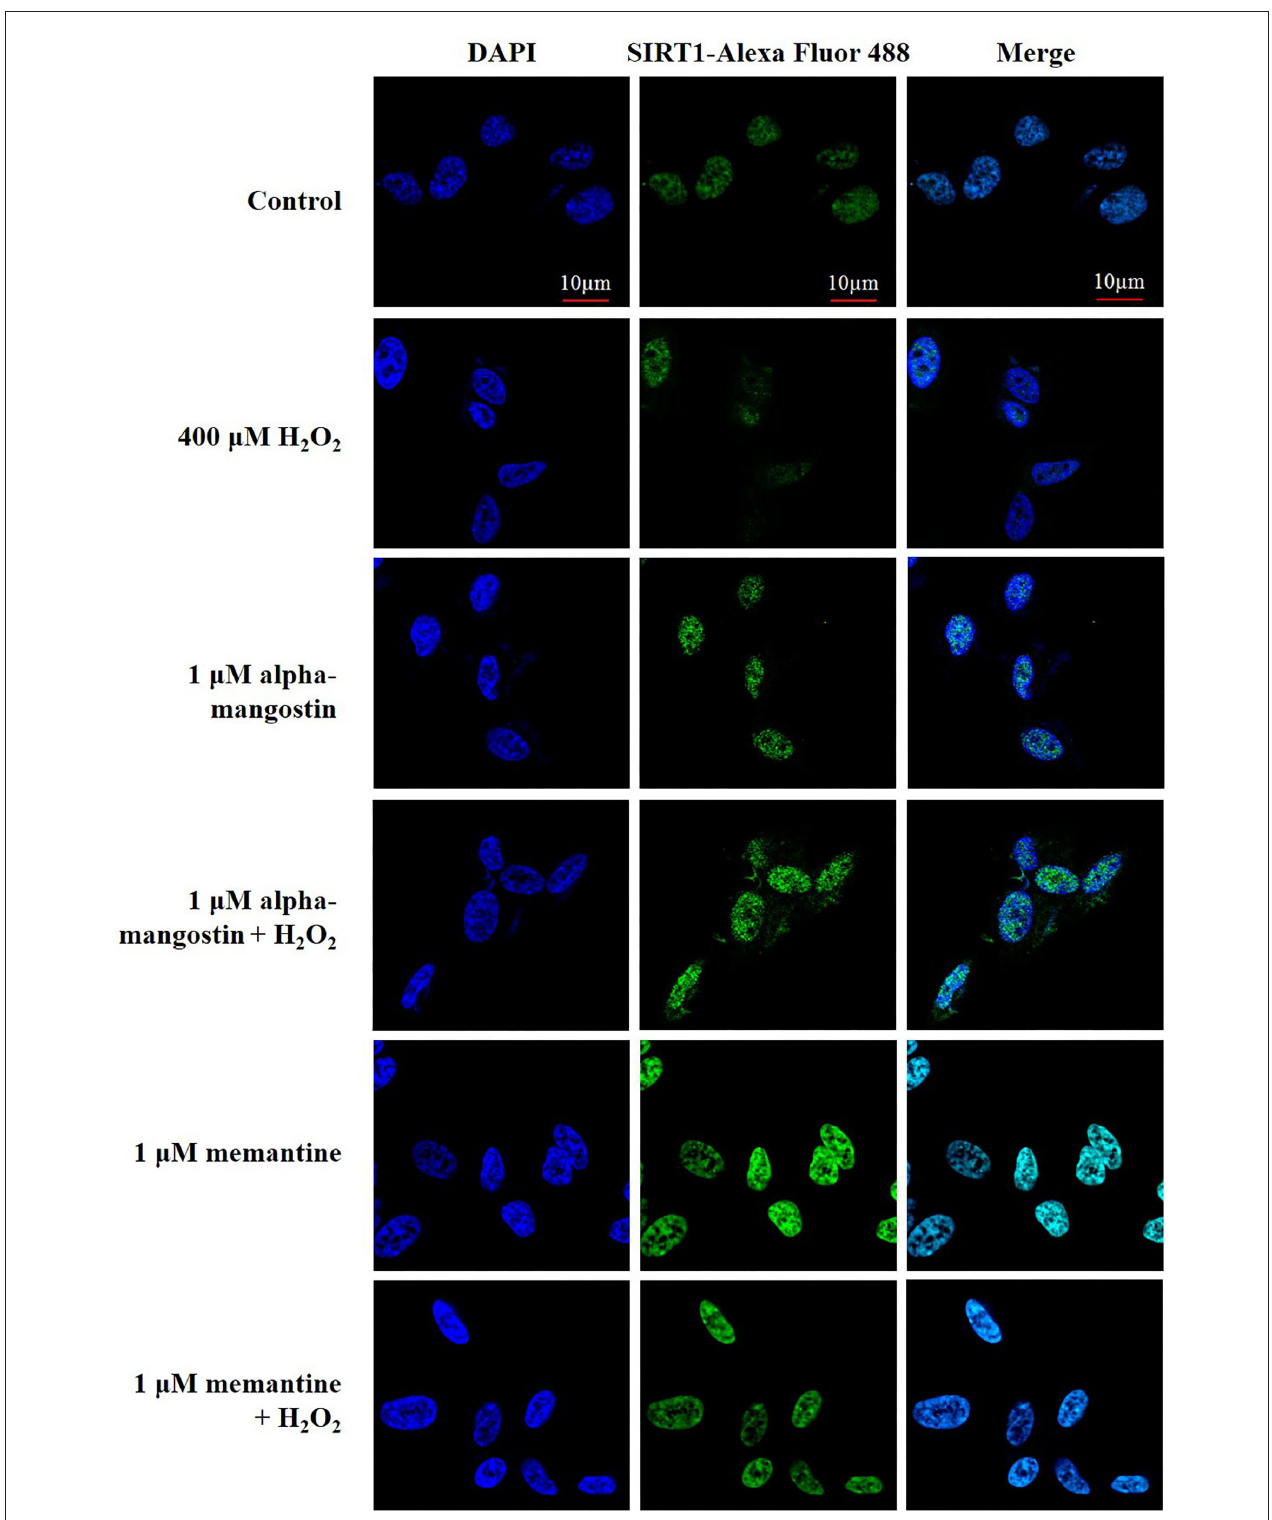
FIGURE 4 | The expression and nuclear translocation of SIRT1 increased along with the pretreatments of 1 µ M alpha-mangostin and memantine in SH-SY5Y cells after the oxidative damage. Double immunofluorescence staining with antibody against SIRT1 (green) and DAPI (blue) of the cells was performed. Scale bars = 10 µ m.